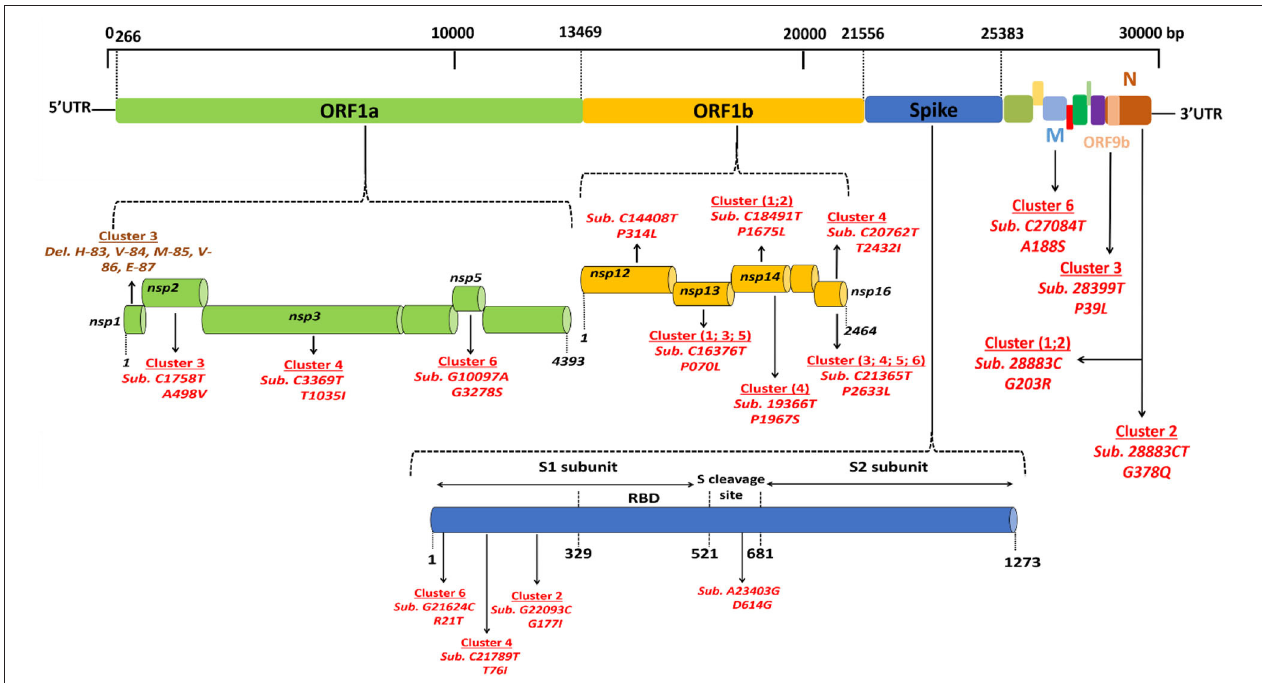
FIGURE 4 | Location of genomic mutations and deletions on the complete nucleotide sequence from different isolates of SARS-CoV-2. Viruses circulating during the first epidemic wave derive from the 19A clade that evolves into two clades: 20A, including viruses from clusters 3, 4, 5, and 6, and 20B, including viruses from clusters 1 and 2. Del means deletion; Sub means substitution.